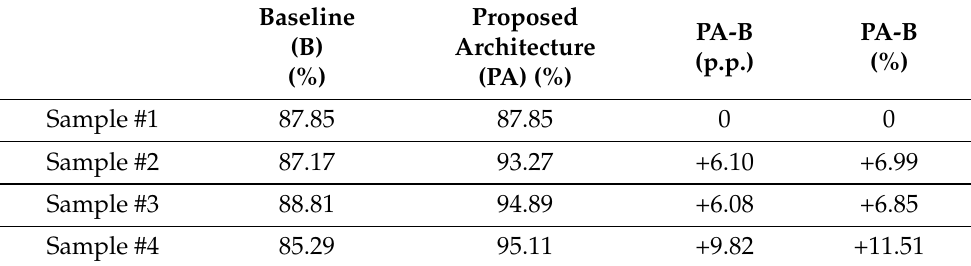
Table 7. Accuracy results of baseline and proposed architecture